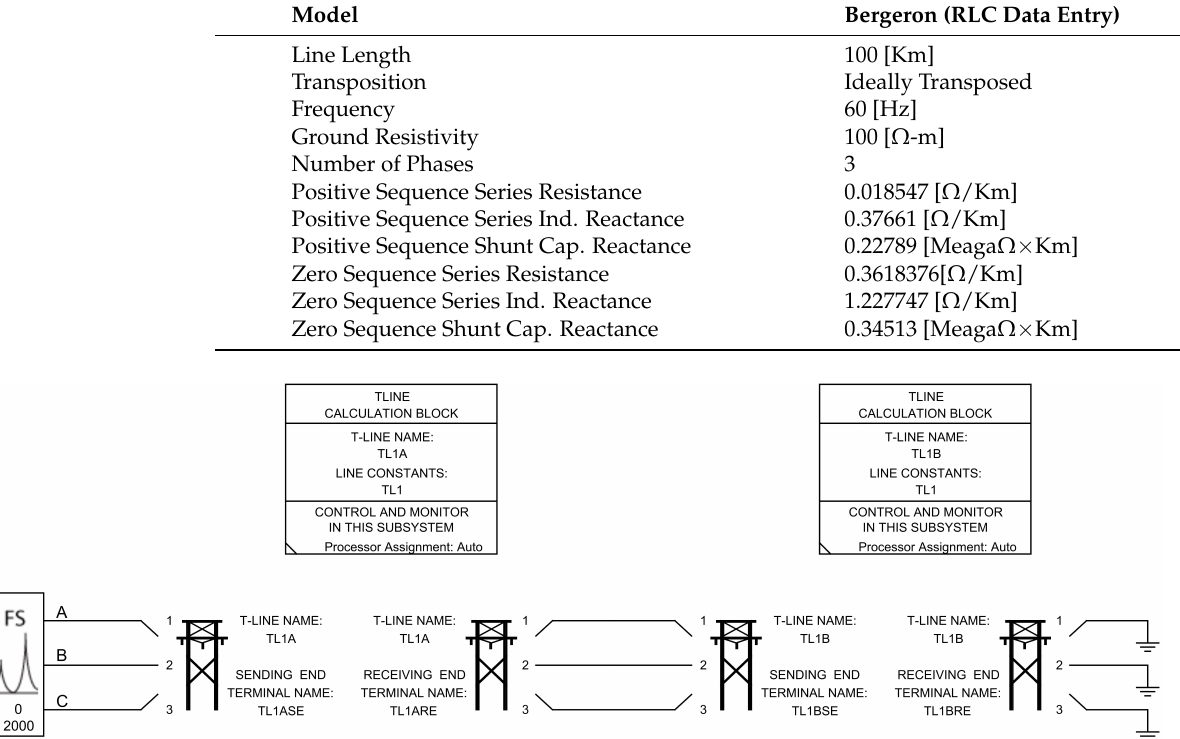
Table 10. Transmission line Bergeron model parameters.